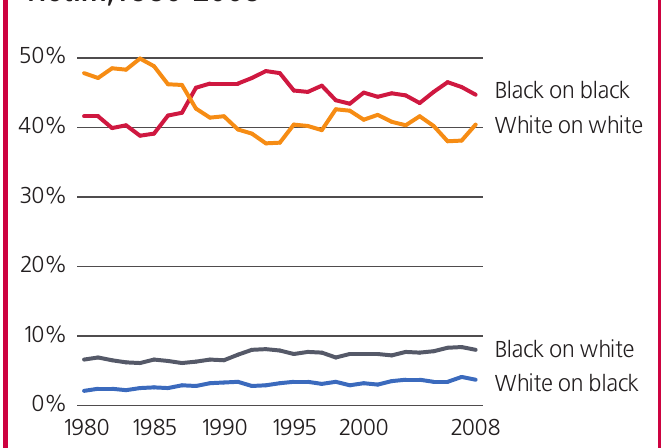
Figure 7. Homicides by race of offender and